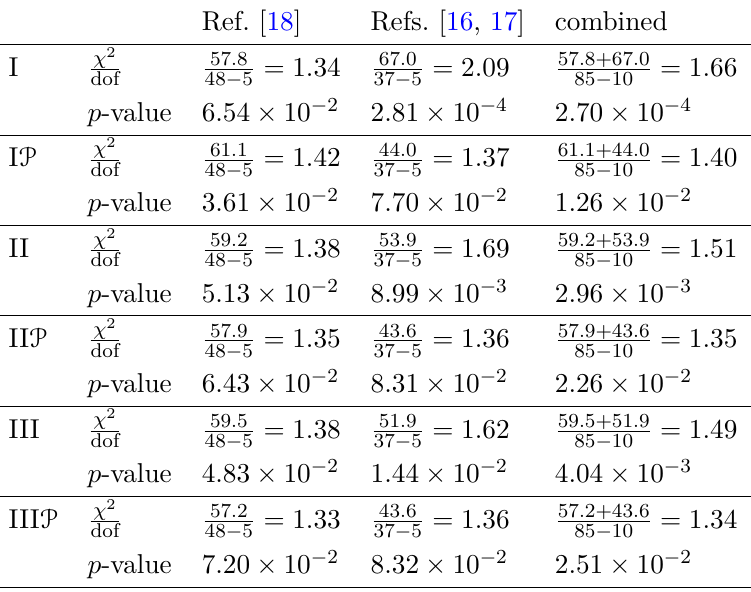
Table 3. The quality of the fit to the γπ data for the different parameterizations of the subtraction